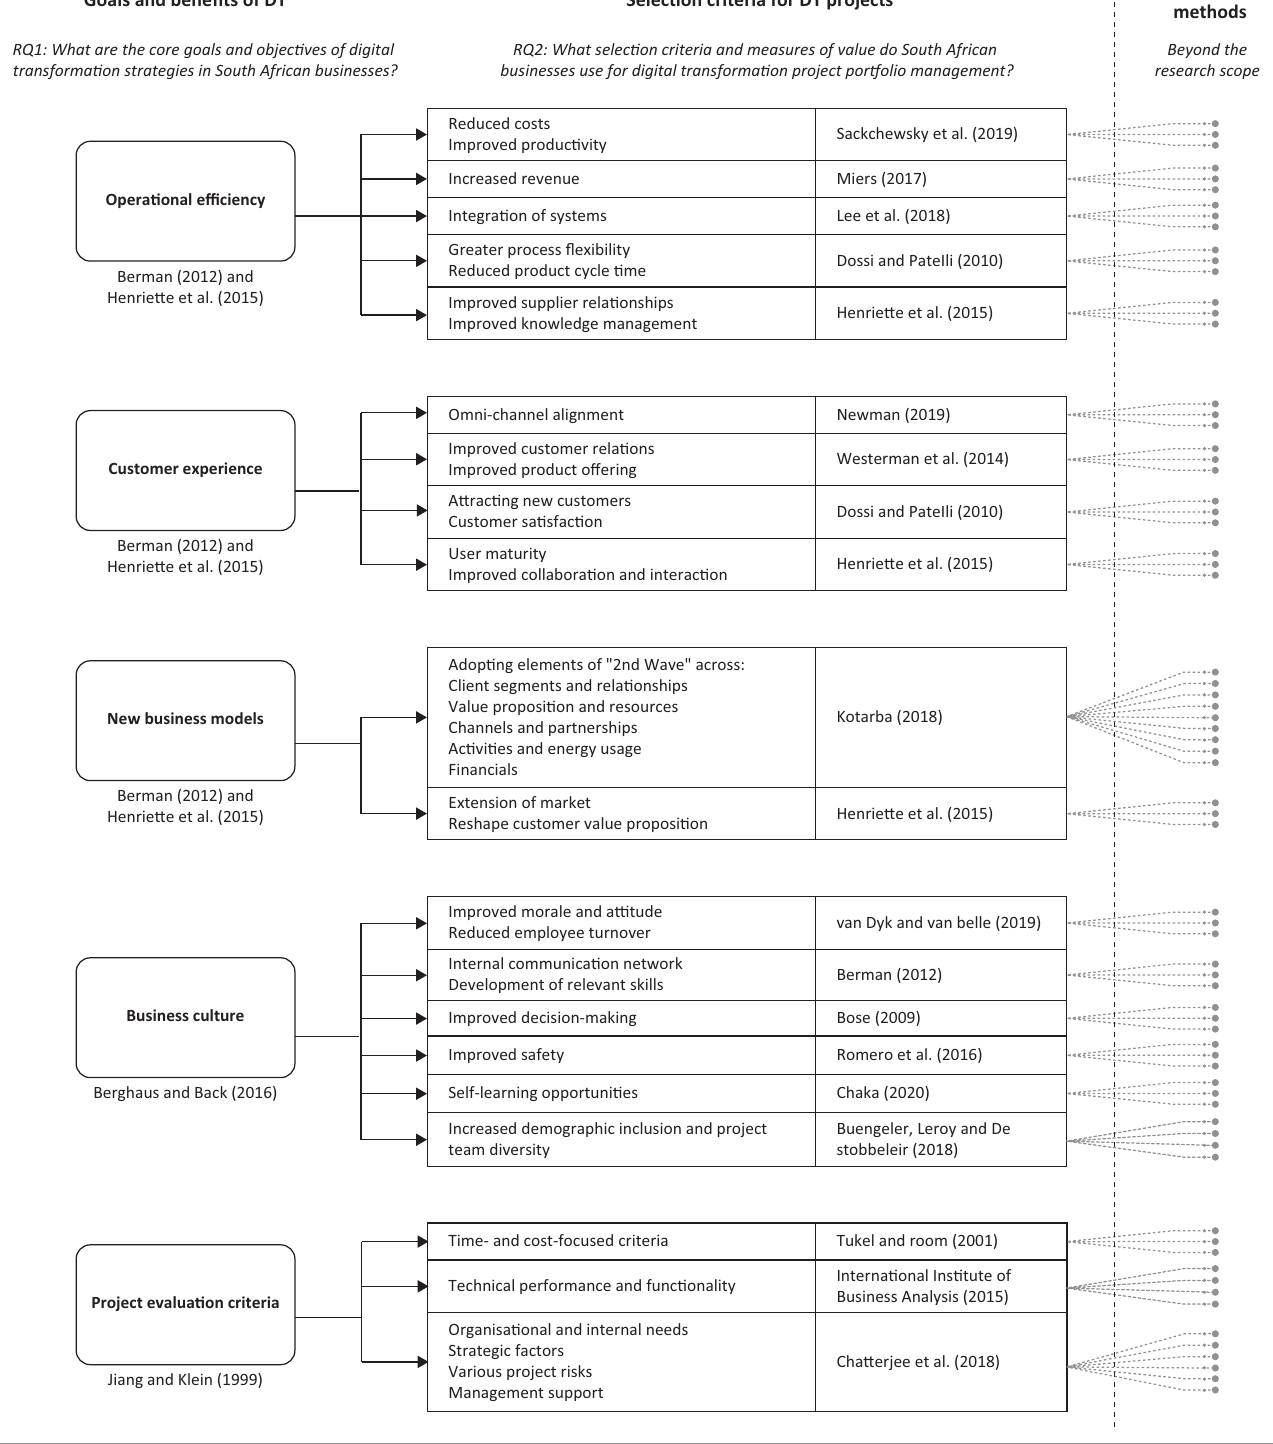
FIGURE 2: Conceptual